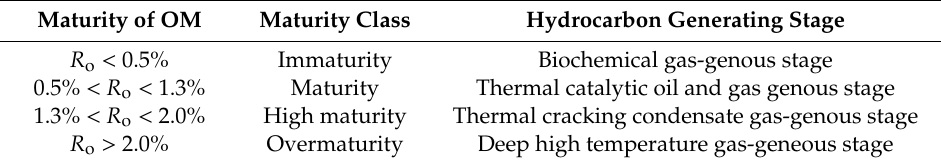
Table 1. Characterization of thermal evaluation of organic matter